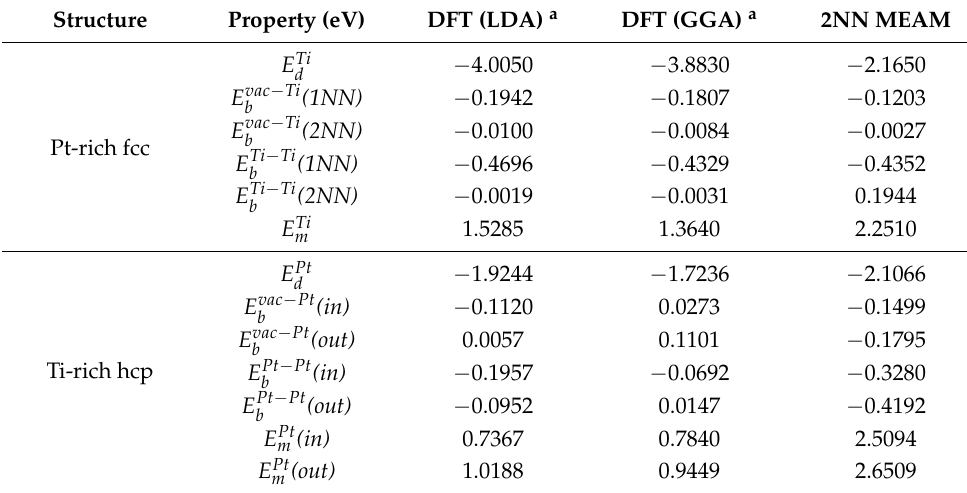
Table 6. Comparison of the predicted energies of binary solid solutions, solute in Pt-rich fcc and Ti-rich hcp structures, obtained from the present DFT calculation (LDA and GGA) and the present interatomic potential. Fcc Pt and hcp Ti were taken as the reference structures for the calculation of dilute heat of solution ( E sol ). The first and second nearest-neighbor vacancy–solute binding energy d ( E vac − sol ) and solute–solute binding energy ( E sol − sol ) in Pt-rich fcc are denoted by “1NN” and “2NN”, b b respectively. The same binding energies, along with the solute migration energy ( E sol m ) in Ti-rich hcp, are denoted using “in” and “out” for the in-basal and out-of-basal configurations, respectively. The negative sign of binding energy indicates a repulsive interaction. Structure Property